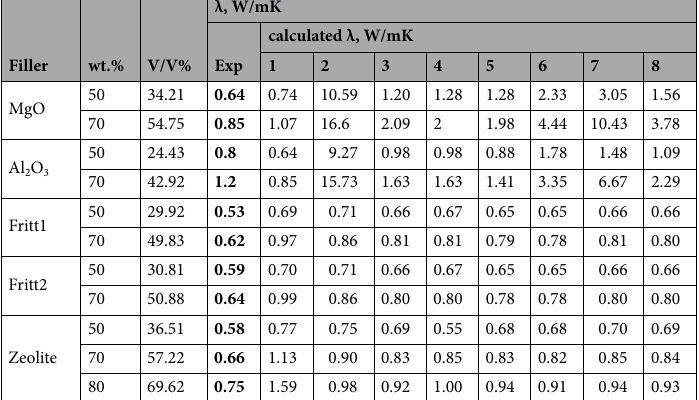
Table 5. Comparisons between experimental results and existing theoretical solutions. 1: Series model, 2: Parallel model, 3: Maxwell model, 4: Maxwell-Eucken model, 5: Lewis-Nielsen’s model, 6: Reciprocity model, 7: EMT model, 8: Bruggemann model. Significant values are in [bold].